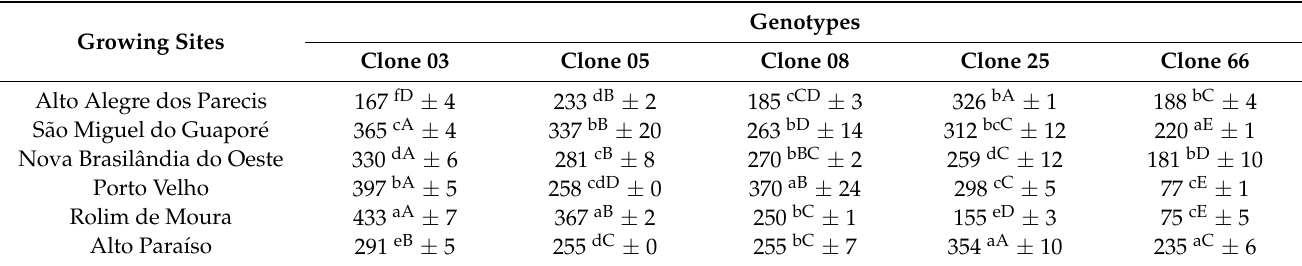
Table 4. The 16- O -methylcafestol contents * (mg 100 g − 1 ) for roasted C. canephora intervarietal hybrids cultivated in different growing